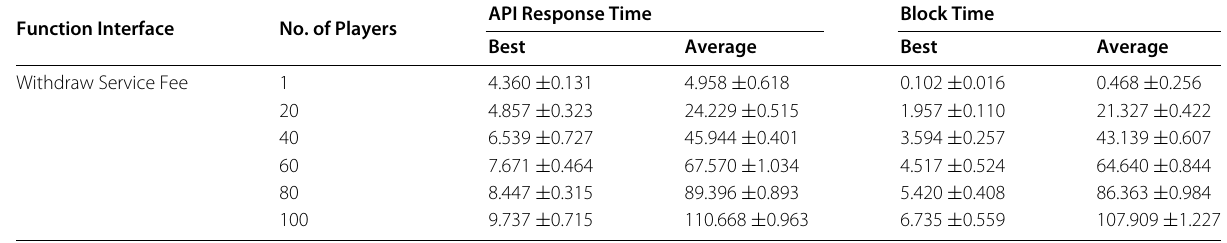
Table 1 Execution latency of the AWESOME contracts with different player numbers (s) ( Continued ) Function Interface